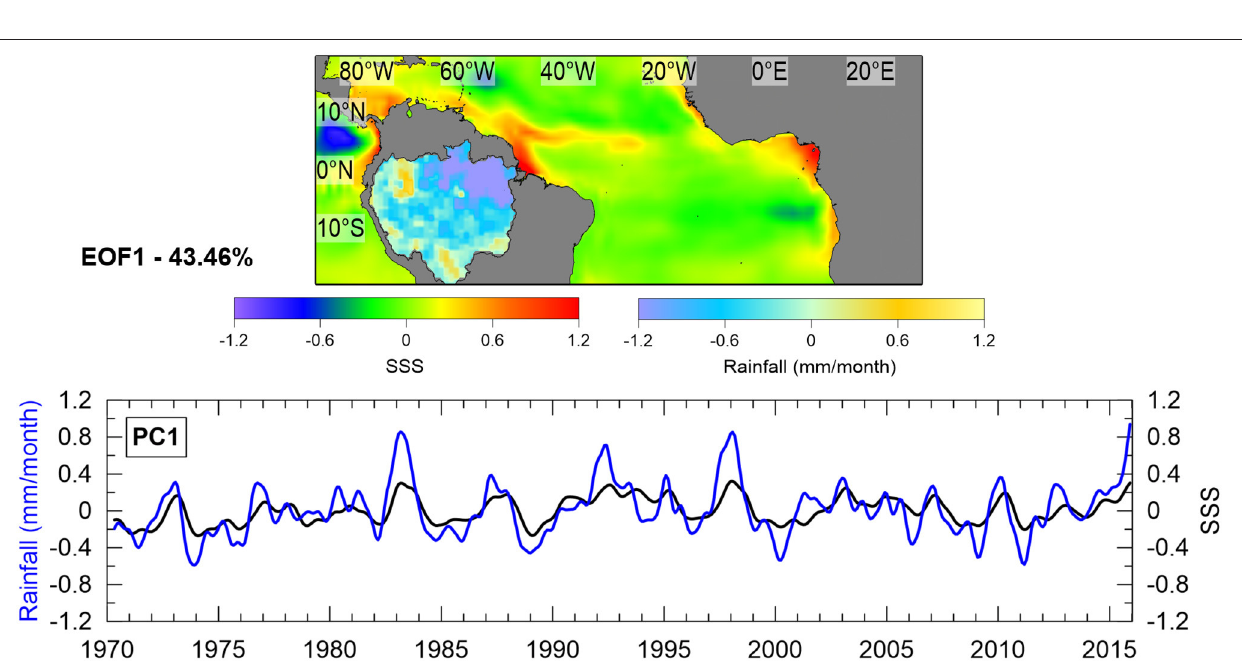
FIGURE 4 | First EOF of 3 month-lagged covariance matrix between rainfall (normalized scale by 10 3 ) and SSS (normalized scale by 10), the Squared Covariance Fraction (SCF) in percentage, and the first Principal Component (PC1).